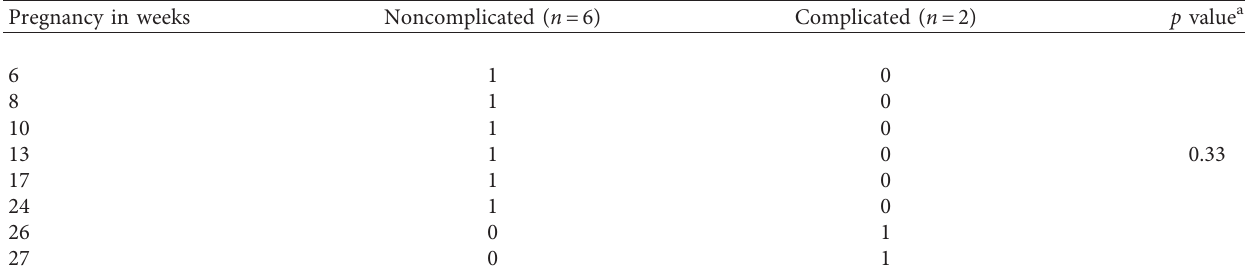
Table 2: Rate of complicated appendicitis based on